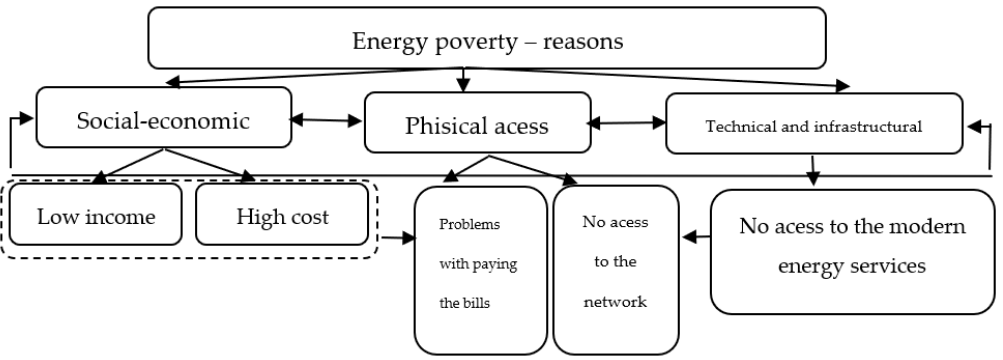
Figure 3. Reasons for energy poverty. Source: own elaborations.